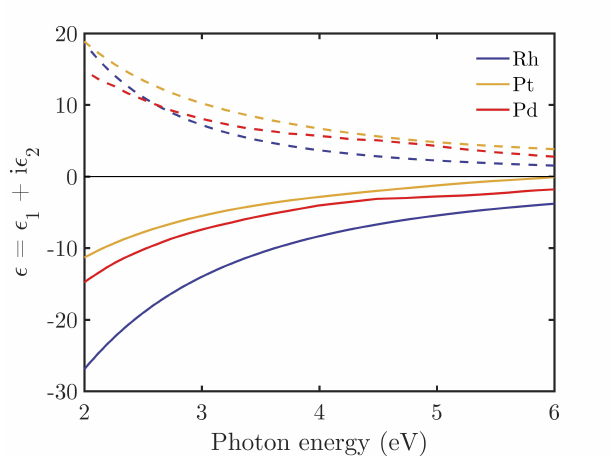
Figure 2. Real ( (cid:101) 1 , solid line) and imaginary ( (cid:101) 2 , dashed line) parts of the complex relative permittivity ( (cid:101) ( ω ) = (cid:101) 1 ( ω ) + i (cid:101) 2 ( ω ) ) of Rh (blue), Pt (yellow) and Pd (red) as a function of the photon energy of the incident